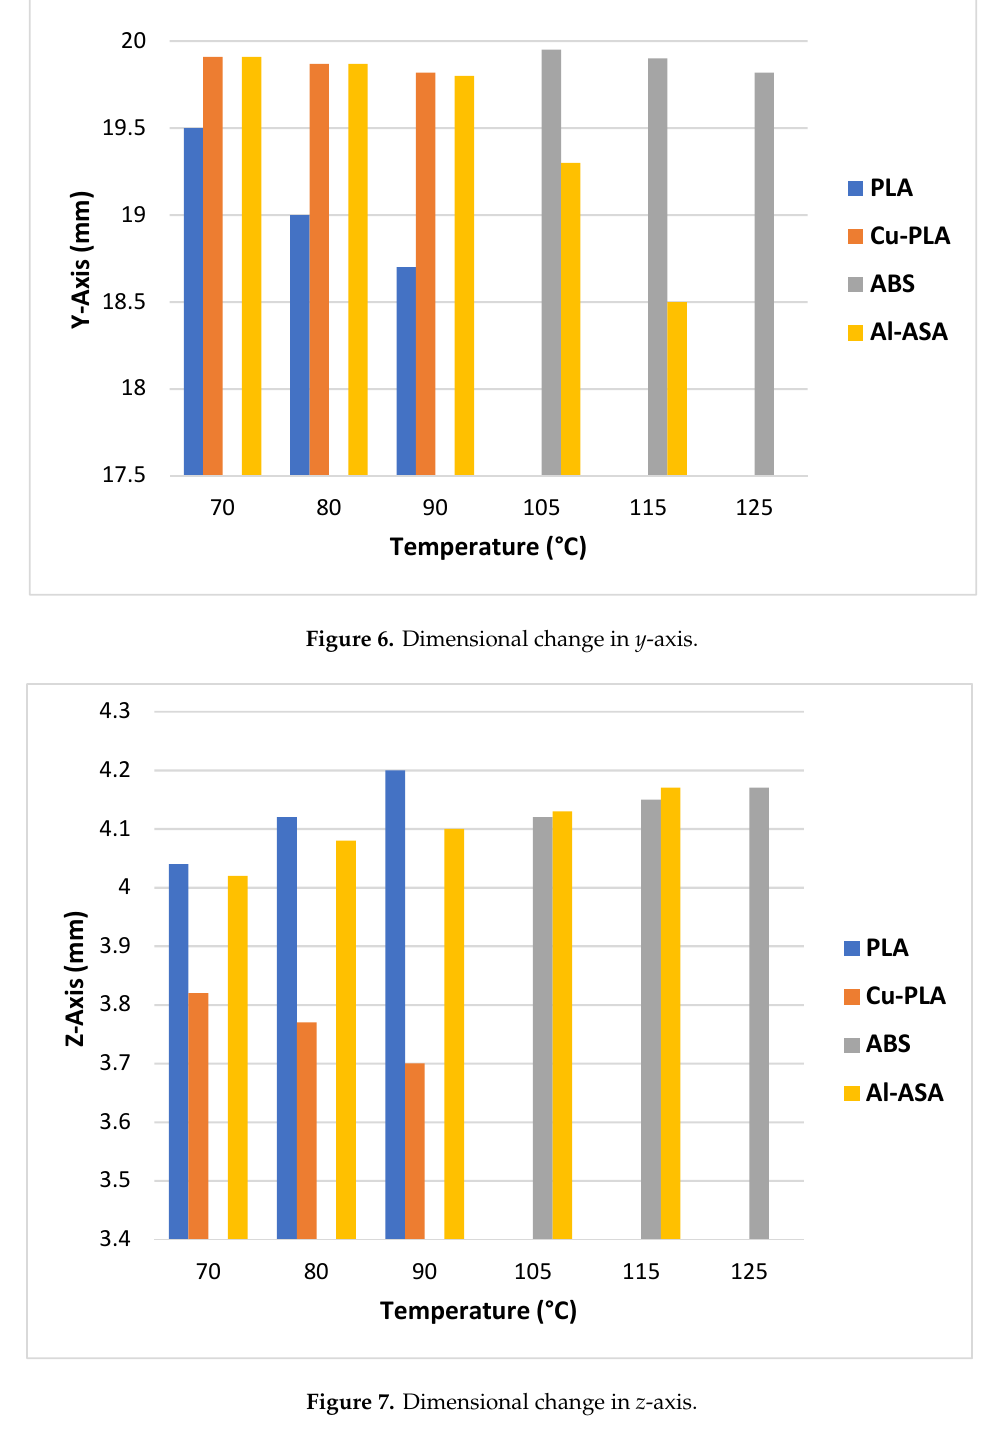
Figure 7. Dimensional change in z -axis.